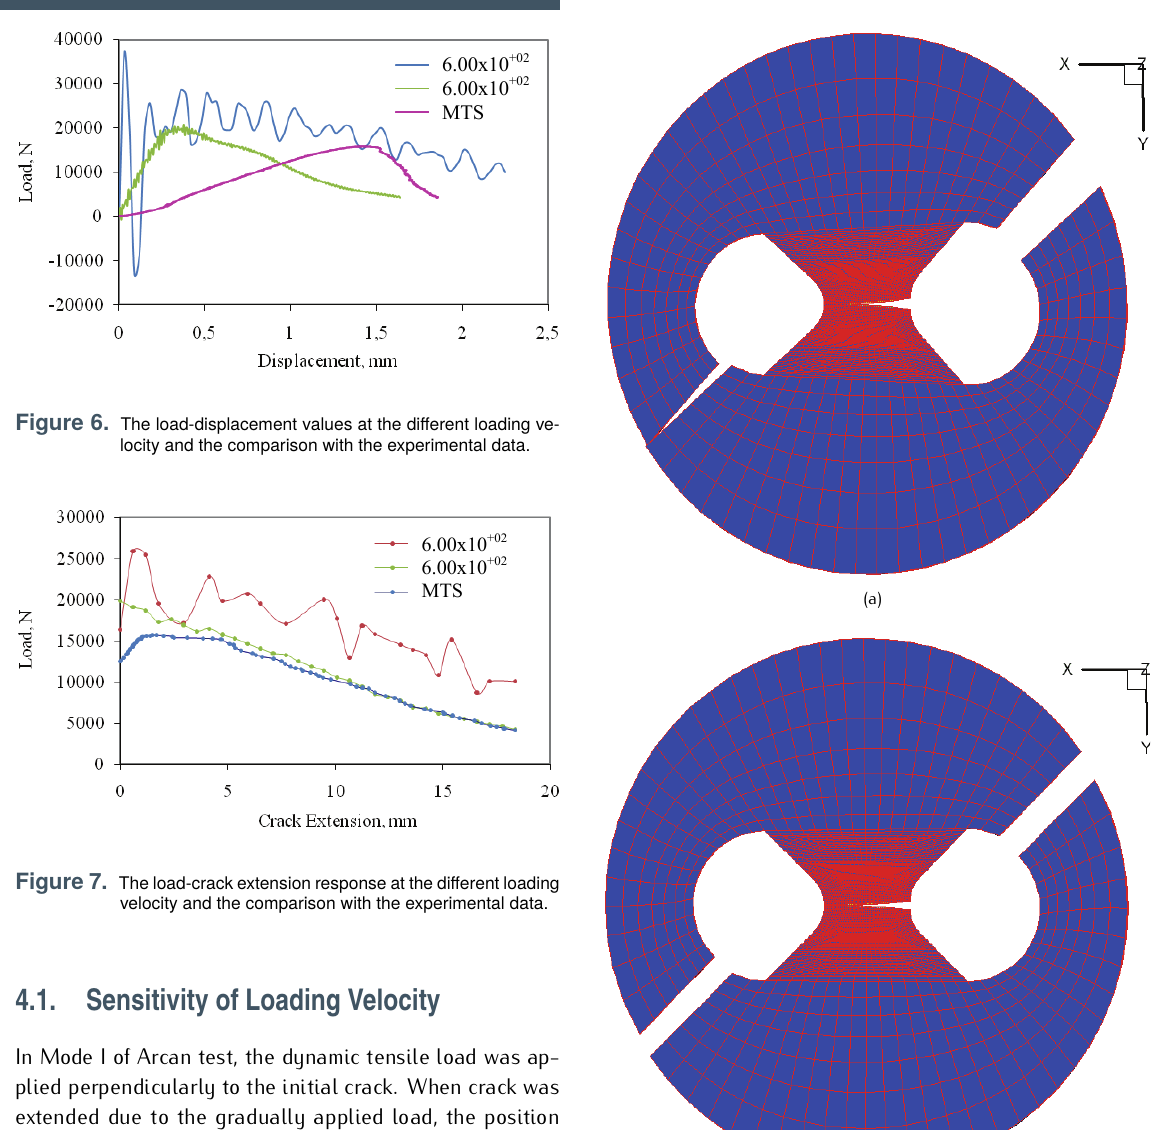
Figure 8: The fixture and specimen response in the different loading velocity (a) 6.0x10 +01 (b) 6.0x10 +02 during same crack